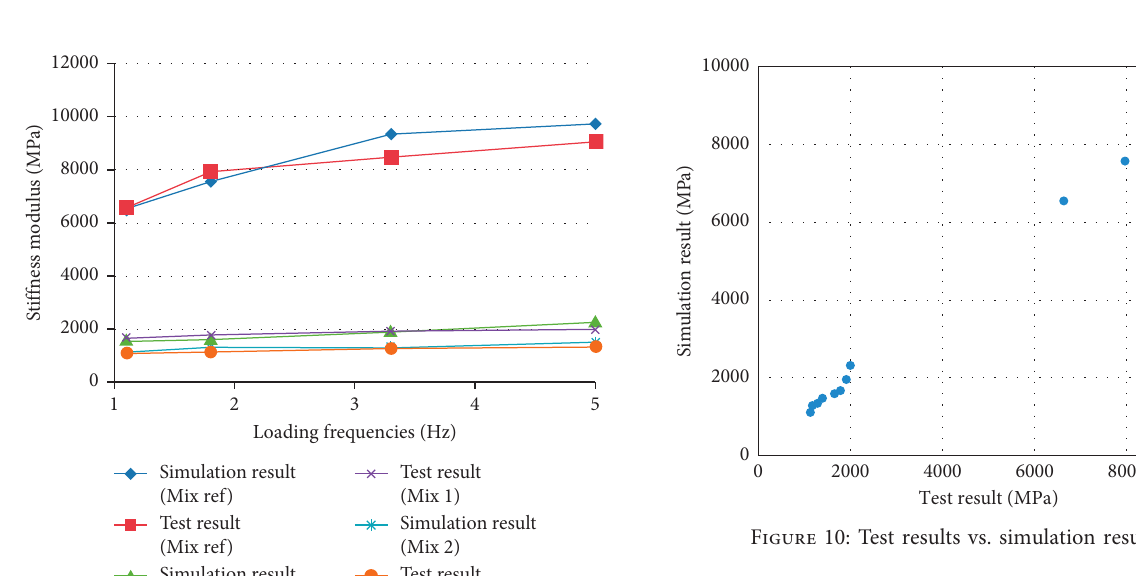
Figure 8: Simulation results in five cyclic at temperature 2 ° C.